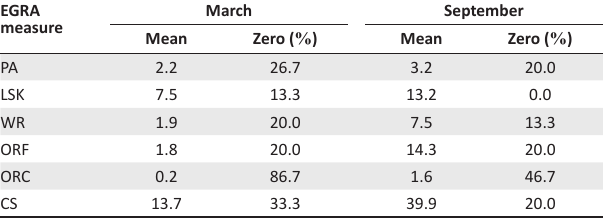
TABLE 6: Descriptive statistics for T3 classroom in school C. EGRA measure